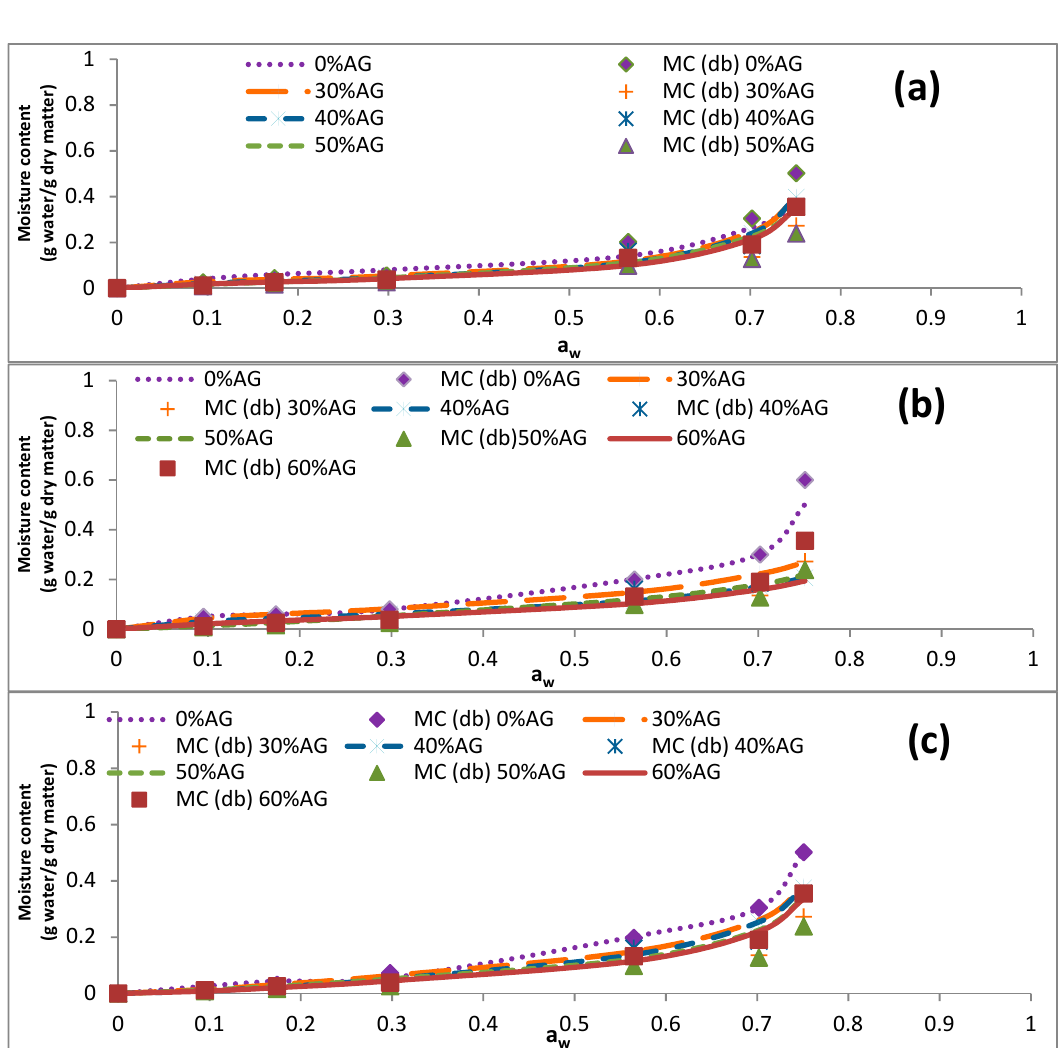
Figure 4. The effect of acacia gum concentration on the equilibrium moisture sorption isotherm of date syrup powders at 60 °C. The experimental data are presented as symbols and the data obtained by fitting the experimental data into mathematical models are presented as lines. ( a ), ( b ), and ( c ) represent the obtained data from BET, GAB and Peleg models. 0% AG: 100% DS-0% AG; 30% AG: 70% DS-30%